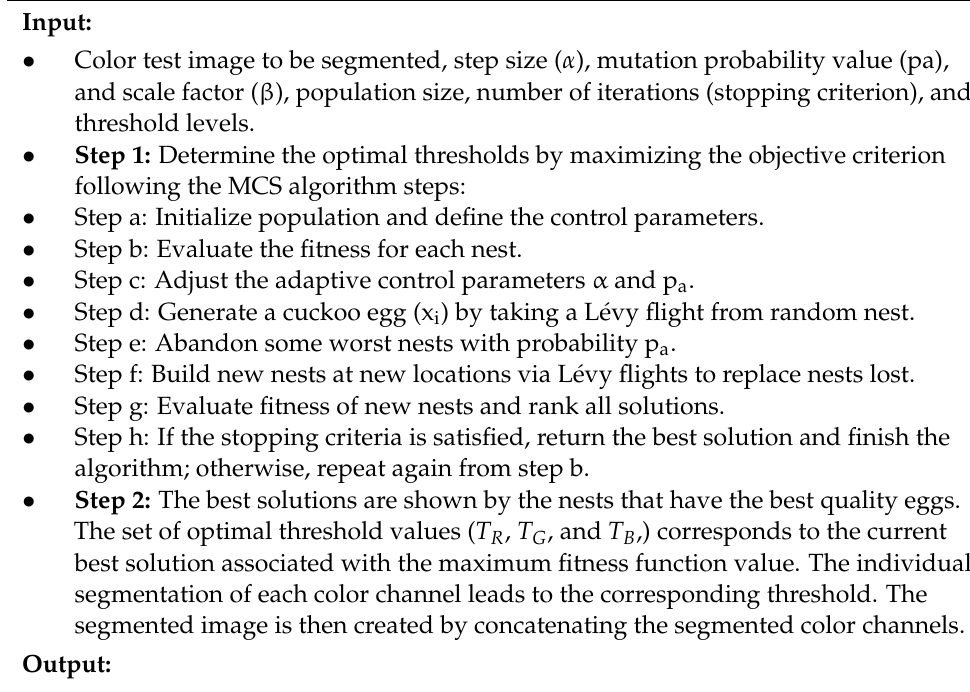
Algorithm 2 Proposed